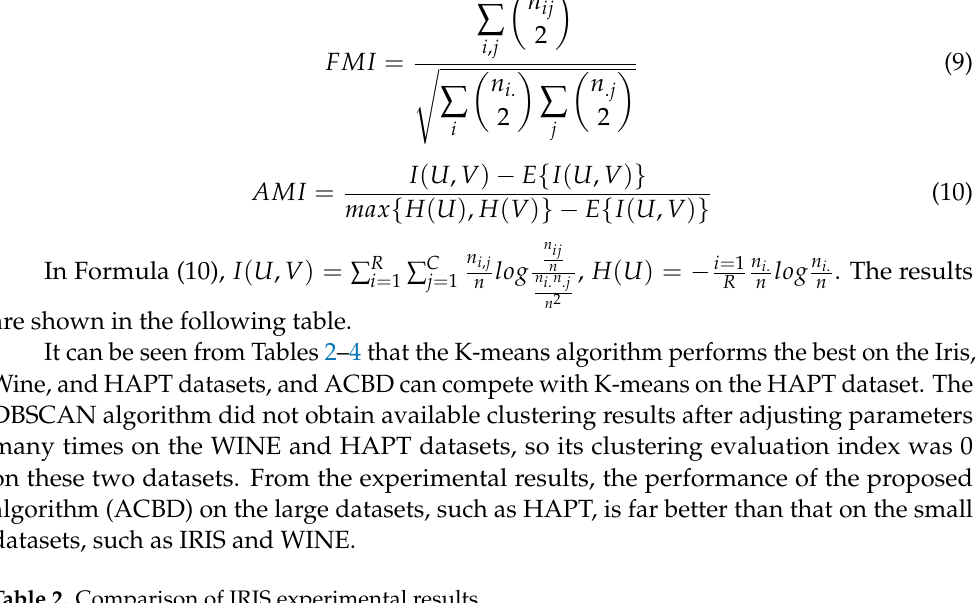
Table 2. Comparison of IRIS experimental results.